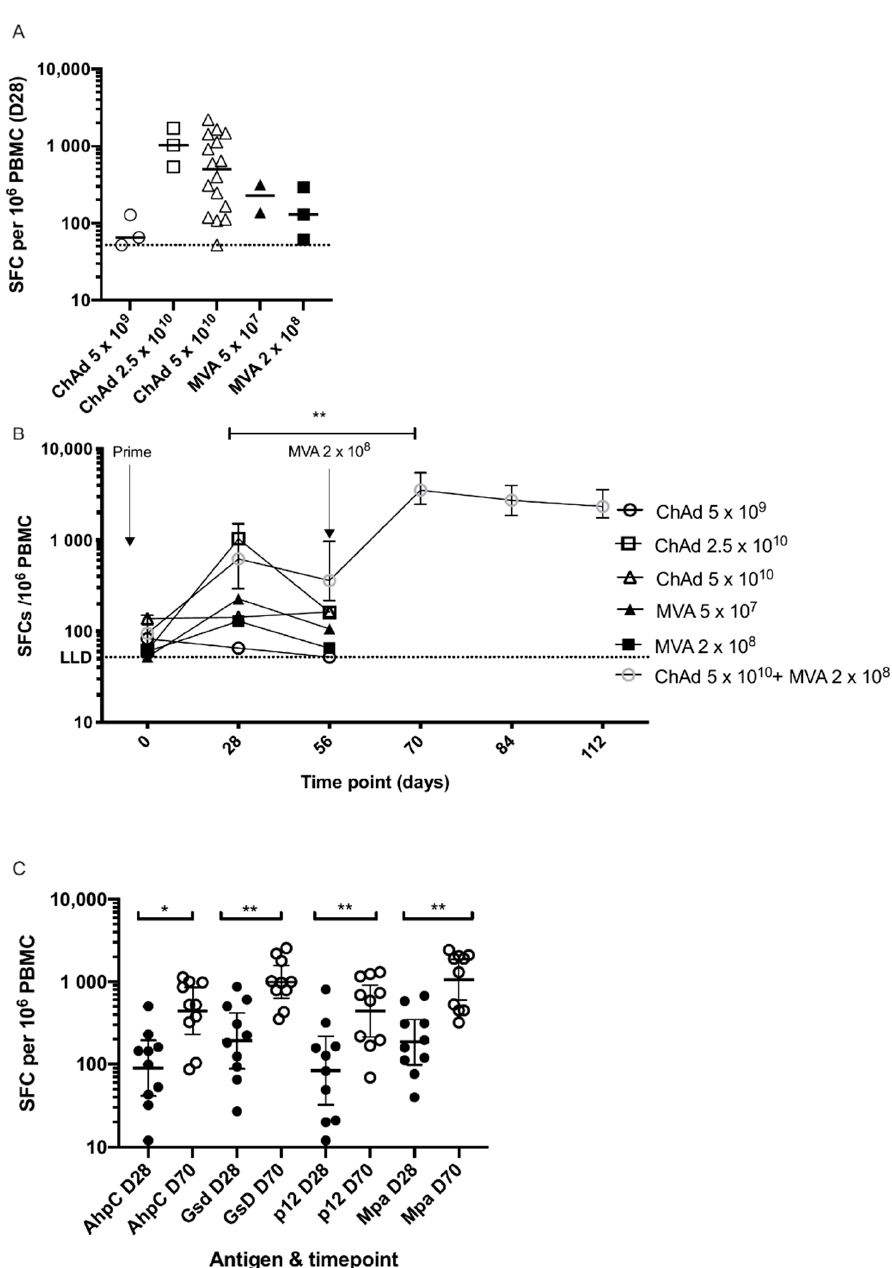
Figure 3. T-Cell immune responses.ELISPOT responses to ChAd and MVA HAV. ( A ) Summed responses to HAV peptide pools at 28 days post prime. Doses shown are vp (viral particles) for ChAdOx2 HAV and pfu (plaque-forming units) for MVA HAV administered to healthy volunteers. Bars represent medians. Dotted line represents ELISPOT lower limit of detection. Lower doses of ChAdOx2 HAV as previously reported also included (5 × 10 9 and 2.5 × 10 10 vp). ( B ). Time course of responses to priming vaccination with ChAd or MVA or prime-boost vaccination. Prime only groups were only followed-up for immune responses at 2 months. Medians with inter-quartile ranges are shown. ** p < 0.01, 2-tailed Wilcoxon matched pairs test for difference in response between day 28 and day 70 in prime-boost group. ( C ). Responses at day 28 and 70 to individual antigens in the HAV vaccine construct from 10 volunteers in group 6 who were boosted with MVA HAV. Summed responses to peptides are shown with bars representing geometric means with 95% confidence intervals. * p < 0.05, ** p < 0.01 2-tailed Wilcoxon matched pairs test for difference in response between day 28 and day 70 in the prime-boost group.